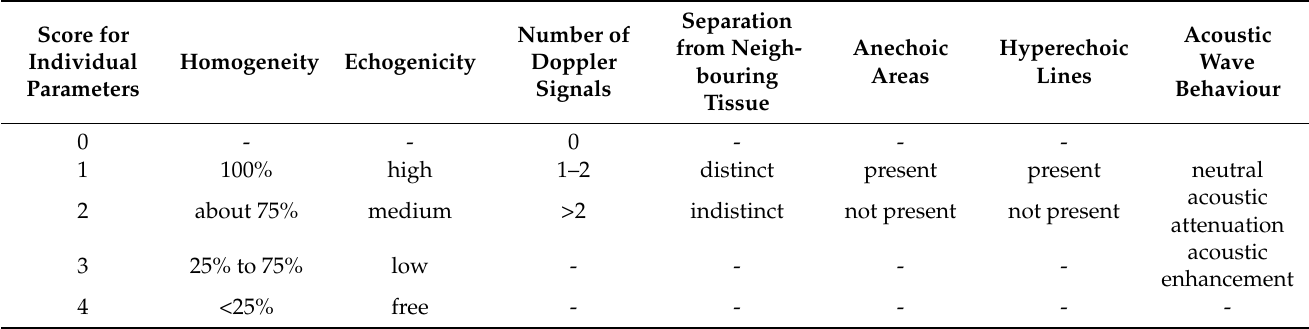
Table 2. Score system of individual sonographically recorded parameters for assessing the sow udders (modified from Sporn [26] and Trasch